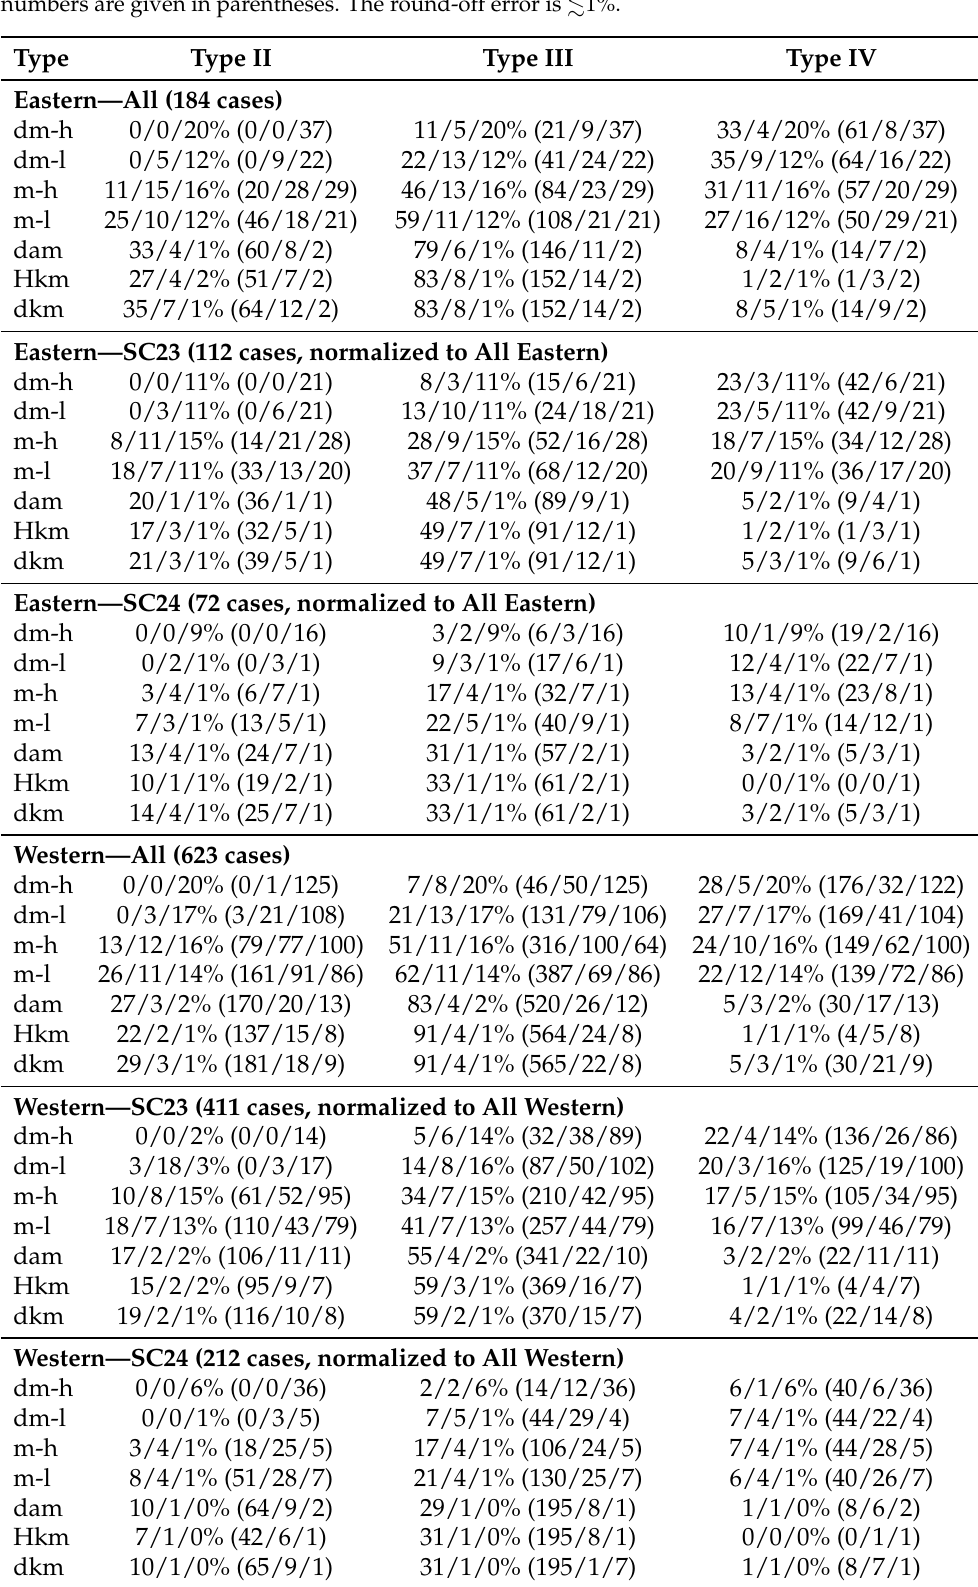
Table 4. Table of the occurrence of radio burst types II, III and IV in the different wavelength ranges for Eastern and Western samples, for All, SC23 and SC24 time periods. The results are shown as: visually identified/uncertain associations with observatory reports/data gaps, in % and the exact numbers are given in parentheses. The round-off error is (cid:46)